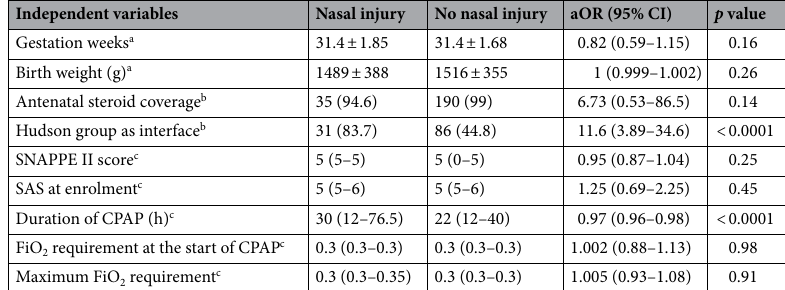
Table 4. Predictors of nasal injury. aOR adjusted odds ratio, CI confidence interval, SNAPPE II score for neonatal acute physiology with perinatal extension II, SAS Silverman Anderson score, CPAP continuous positive airway pressure, FiO 2 fraction of inspired oxygen. a Mean (standard deviation). b n (%). c Median (inter quartile